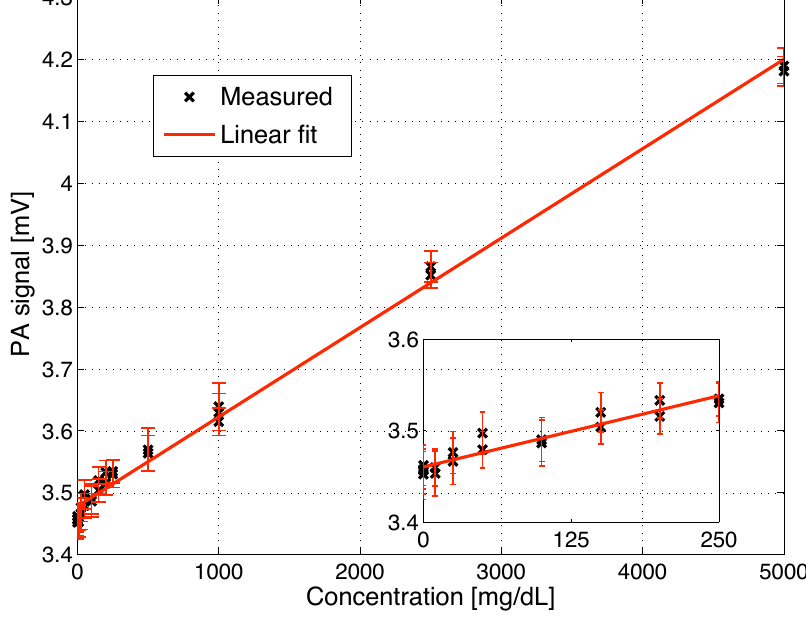
Figure 5. PA signal versus glucose concentration in aqueous solutions. The measurements were conducted a 1,034 cm − 1 with an integration time of 1 s and a modulation frequency of 117 Hz. The error bars correspond to twice the standard deviation ( i.e ., ± σ ) using a lock-in integration time of 1 s. The inset depicts the concentration range 0–250